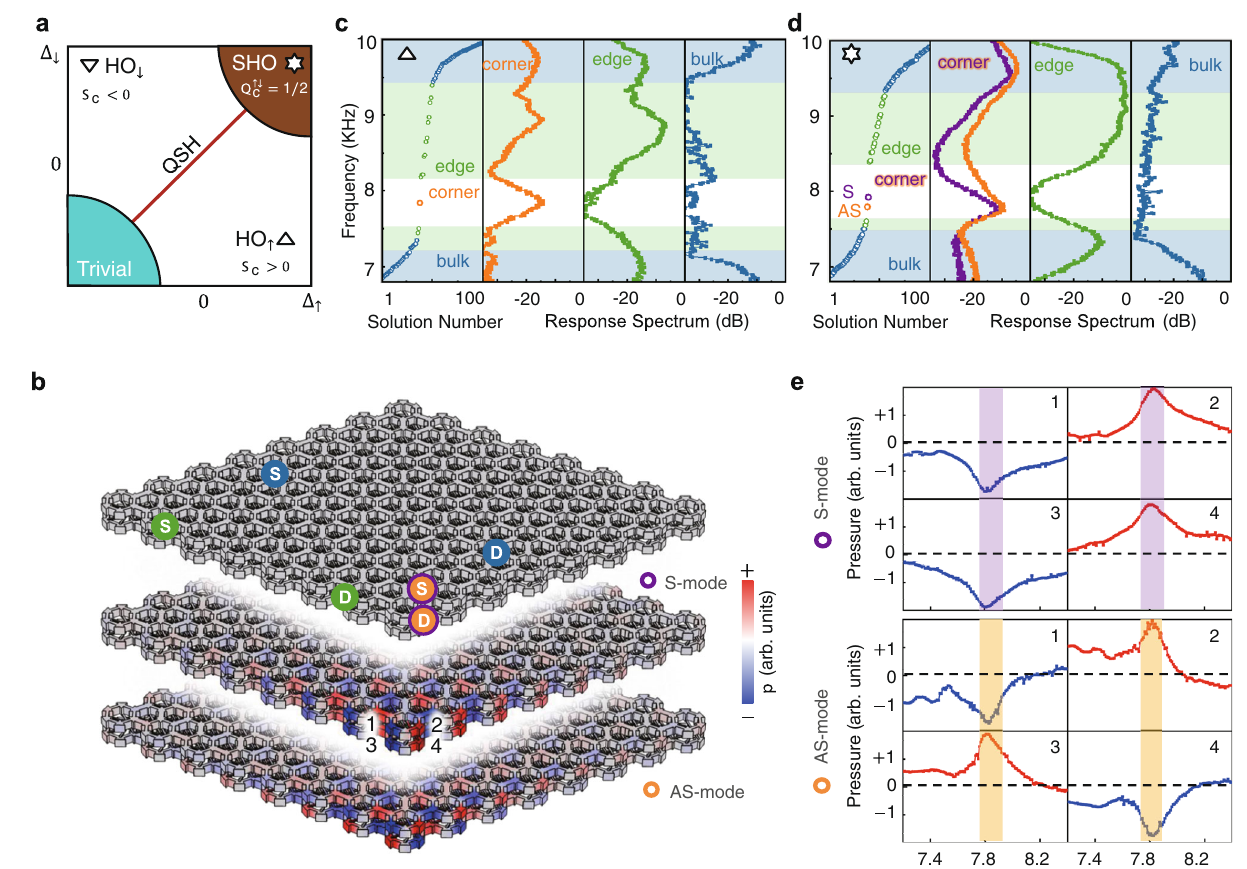
Fig. 5 | Response spectra for HO and SHO phases. a Phase diagram at λ =1 slice. The insets show corner charges. b Sample structure for measurements (upper panel).Theblue,green,andorangemarkersS(D)denotethebulk,edge,andcorner sites, respectively, for the placement of acoustic sources (detectors) in experi- ments. The middle (lower) panel shows the simulated fi eld distribution for the